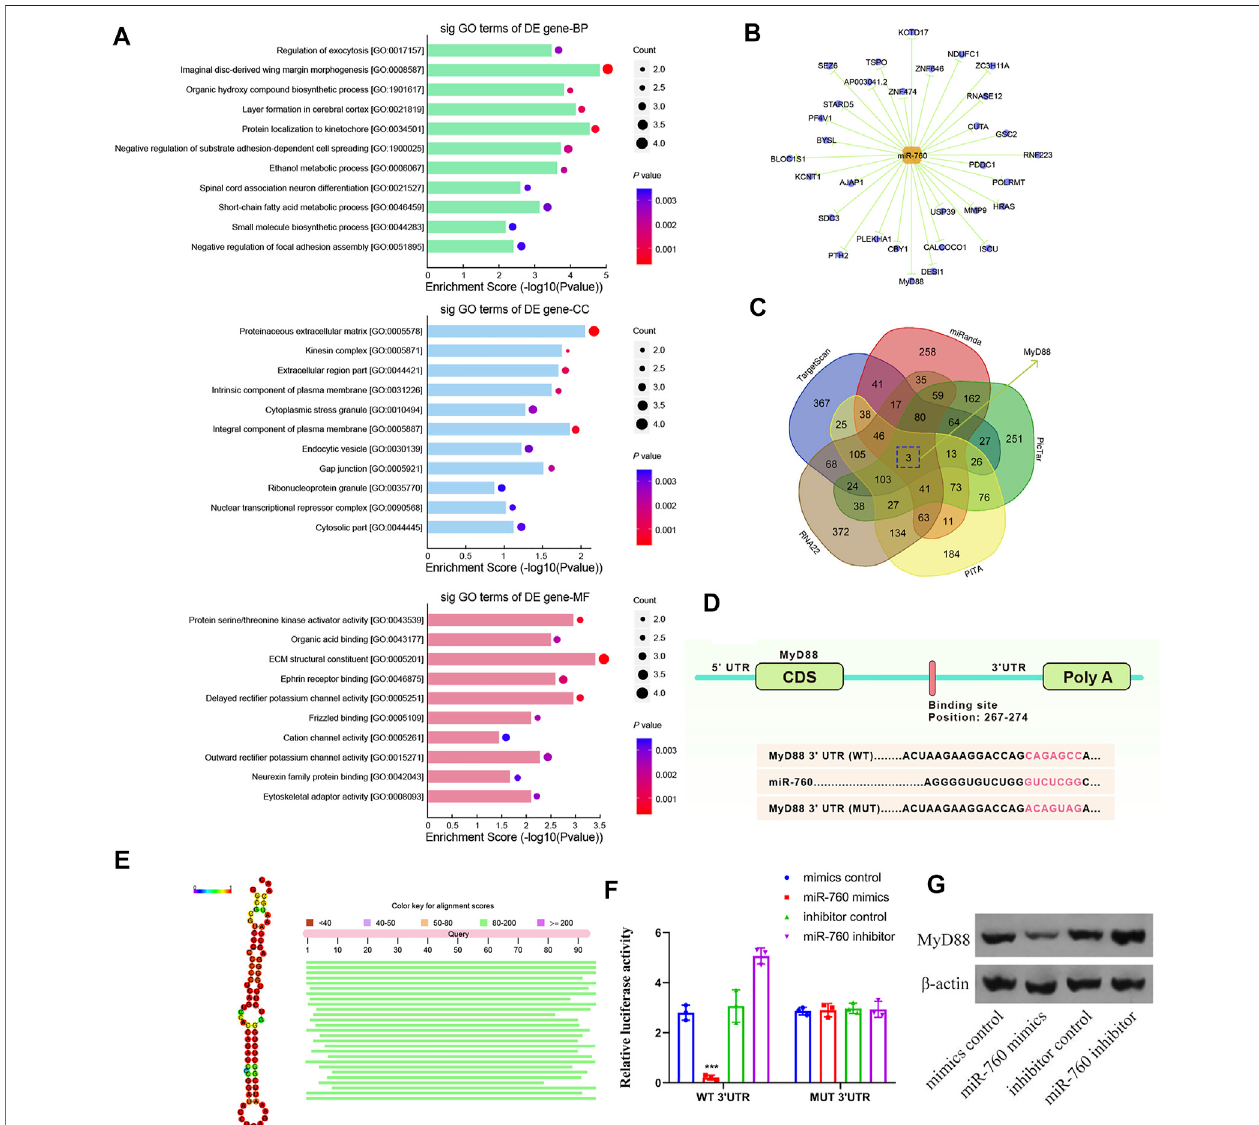
FIGURE 3 | Identi fi cation of MyD88 as a target of miR-760. (A) Downregulated GO terms with the most signi fi cant p values for biological processes, molecular function, and cellular component. (B) Cytoscape was used to con fi rm the target of miR-141. (C) Venn diagram displaying miR-760 computationally predicted to target MyD88 by fi ve different prediction algorithms: miRanda, TargetScan, RNA22, PicTar, and PITA. (D) Sequence alignment of a putative miR-760-binding site within the 3 ′ UTR of MyD88 mRNA shows a high level of sequence conservation and complementarity with miR-760. (E) High conservation of miR-760. (F) The wild- or mutant-type MyD88 3 ′ UTR reporter plasmid was co-transfected with miR-760 mimics or inhibitor into cultured primary human NP cells. Luciferase activity was measuredaftertransfection.n=3replicatespergroup,*** p < 0.001byone-wayANOVAtestfollowedbyTukey ’ sposthoc. (G) MyD88expressionlevelwasdetectedby western blot. n = 3 replicates per